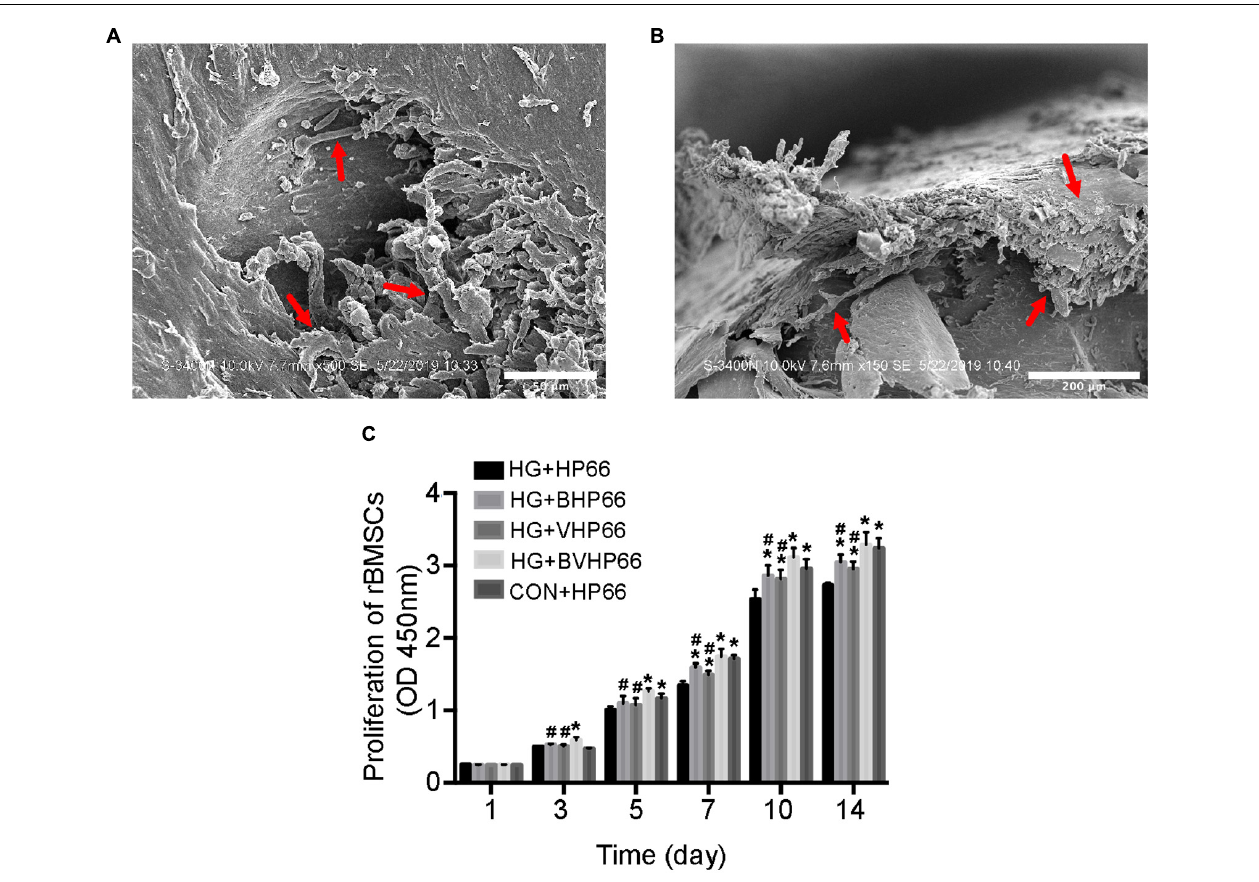
FIGURE 5 | Adhesion and proliferation of rBMSCs. SEM micrographs of rBMSCs adhered to the surface of BVHP66 scaffold after cultured for (A) 7 and (B) 14 days. (C) The proliferation of rBMSCs in different groups on different days. Scale bar = 50 and 200 µ m. n = 3 for each group, data were expressed as mean ± SD. * P < 0.05, vs. HG + HP66 group; # P < 0.05, vs. HG + BVHP66